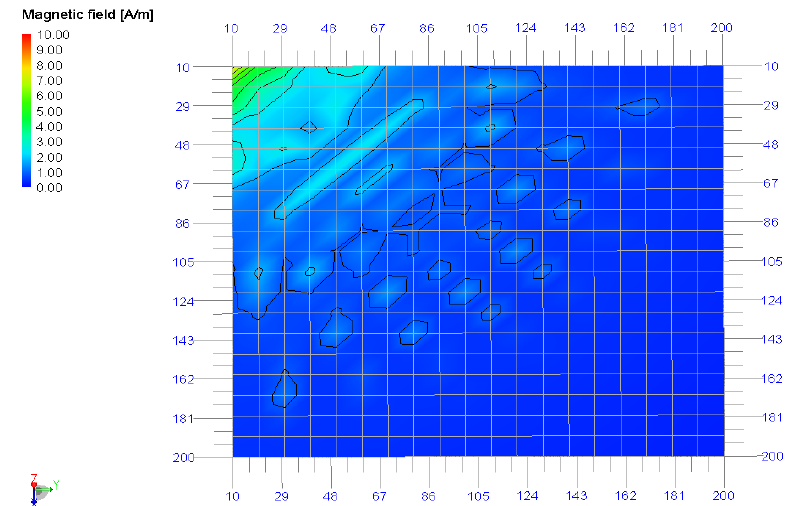
Figure 8. Distribution diagram of ground electric field under antenna (quarter area).